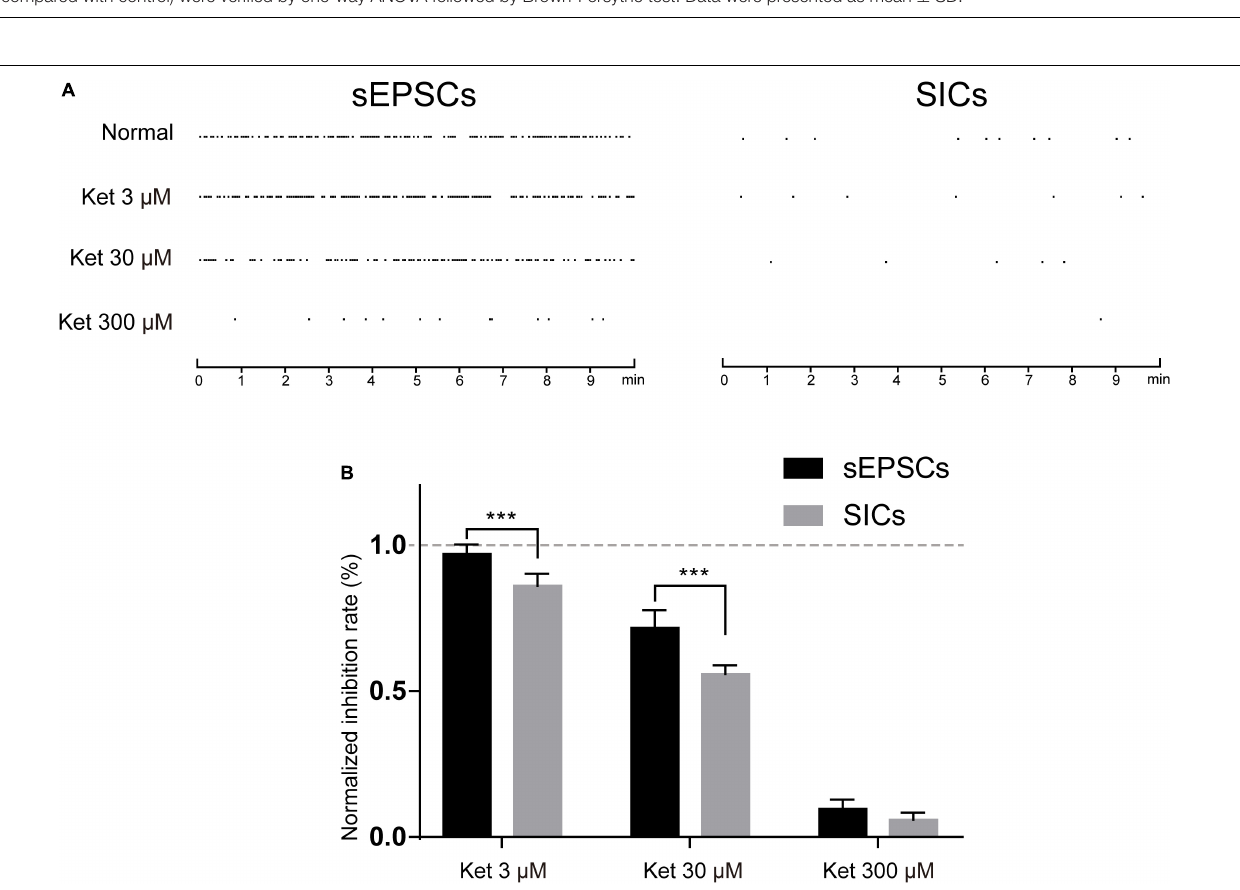
FIGURE 6 | The inhibitory effects of ketamine on mEPSCs and SICs. (A) events marker of mEPSCs (left) and SICs (right) in a representative 10 min period. Ketamine inhibited both mEPSCs and SICs in a concentration dependent manner. (B) Normalized inhibition rate of ketamine on mEPSCs and SICs. Differences with statistically significant ( ∗∗∗ p < 0.001, compared with control) were verified by two-way ANOVA with post tests. Data were presented as mean ± SD.